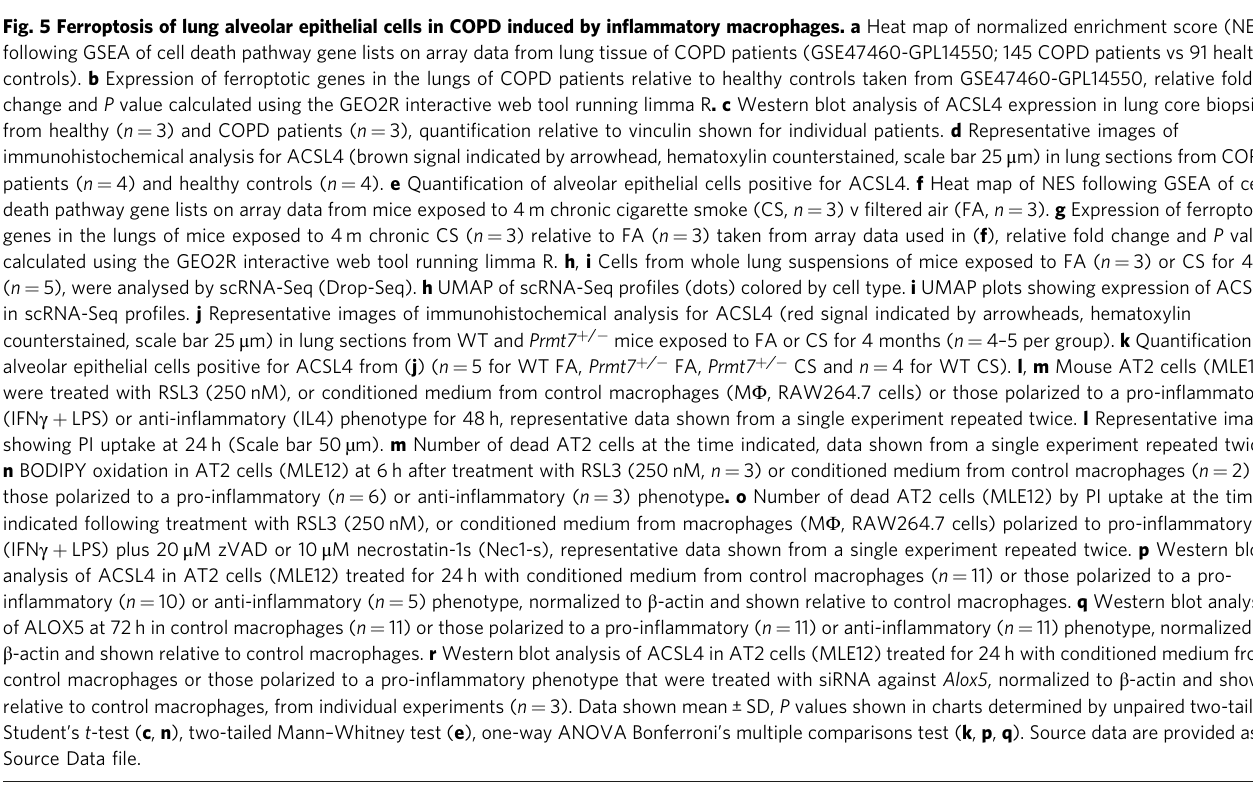
(Supplementary Fig. 23). Further, in fl ammatory macrophages via ALOX5-mediated release of LTB4 induced increased expression of ACSL4 in AT2 cells increasing susceptibility to CS-induced ferroptotic cell death and tissue injury.